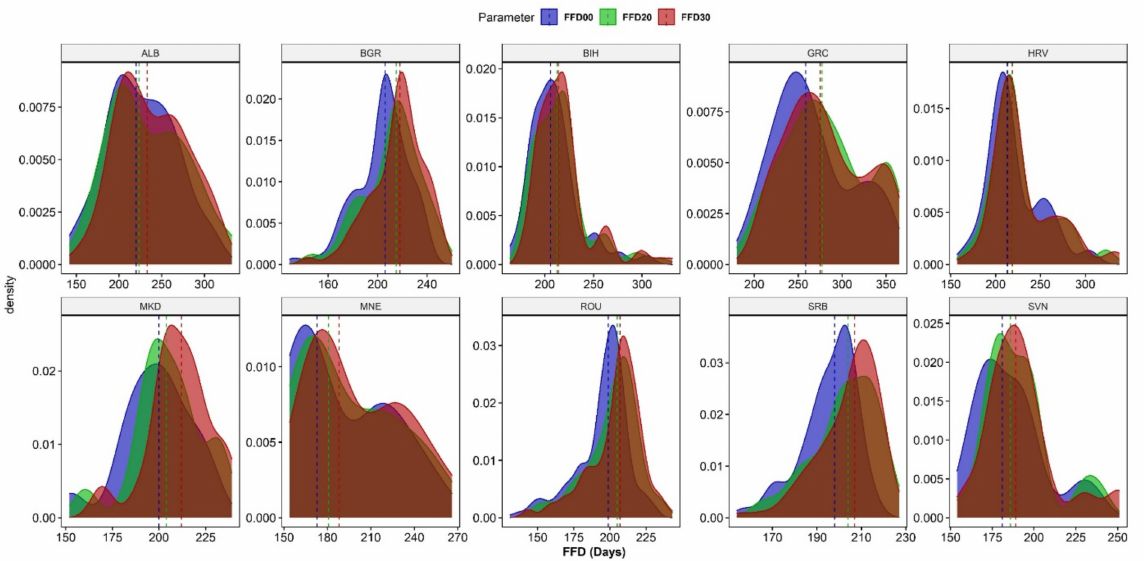
Figure 11. The density plots of the Free of Frost Days (FFD) period for the reference period and the 2020 and 2030 horizons, per country. The vertical lines represent the median